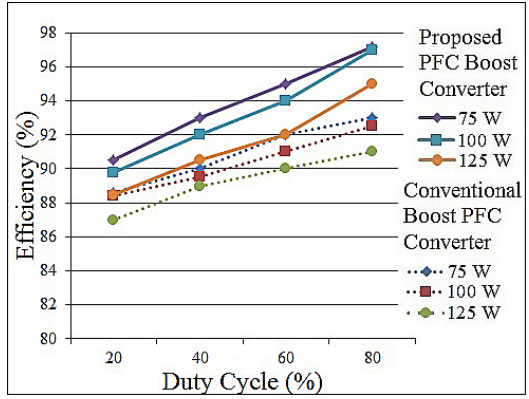
Figure 9. Duty cycle and efficiency.